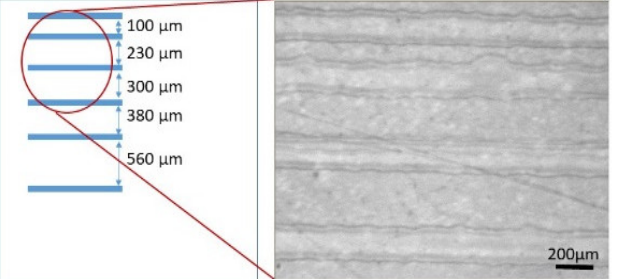
Figure 4. Scheme of deposited PVA pattern ( left ) and optical microscopy image ( right ) of an array of PVA lines printed onto PLA substrate, obtained by fixing the drop space (DS = 15 μm) and the overlapped layer number (2) as well as changing the gap between consecutive lines. The measured line width and thickness are 190 nm and 290 nm, respectively.